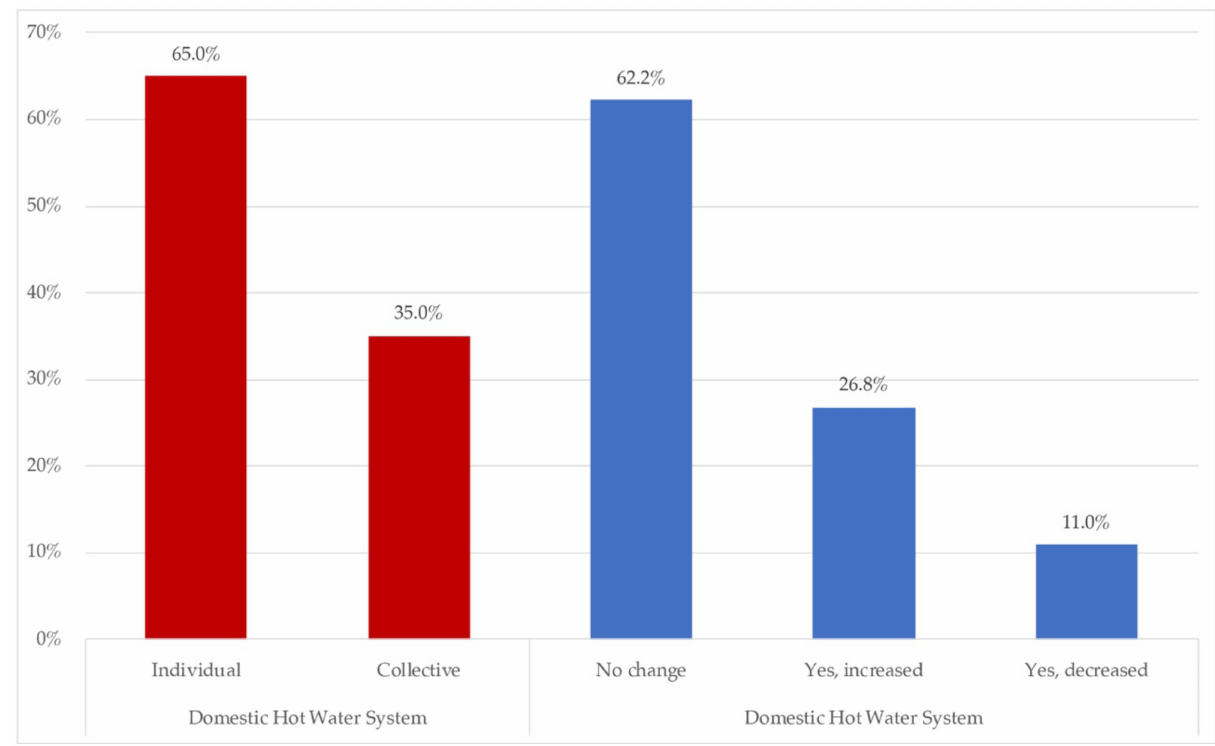
Figure 11. Type of domestic hot water system and perception of its frequency of use during